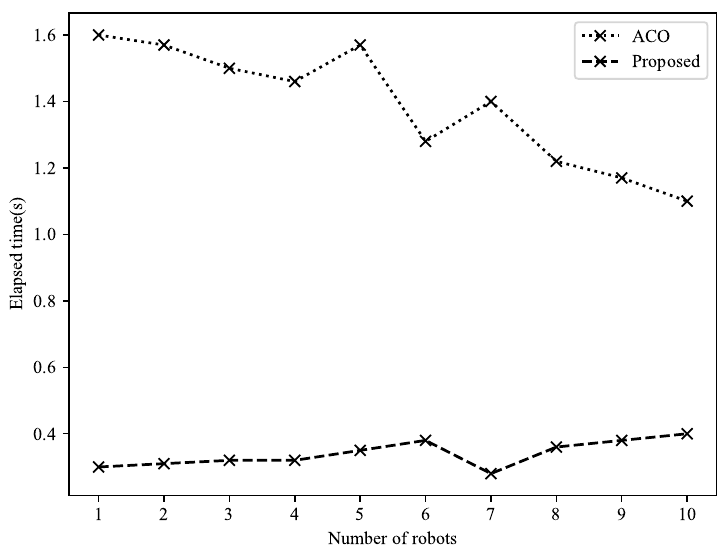
Figure 10. Elapsed time graph of the proposed method for number of UAVs.